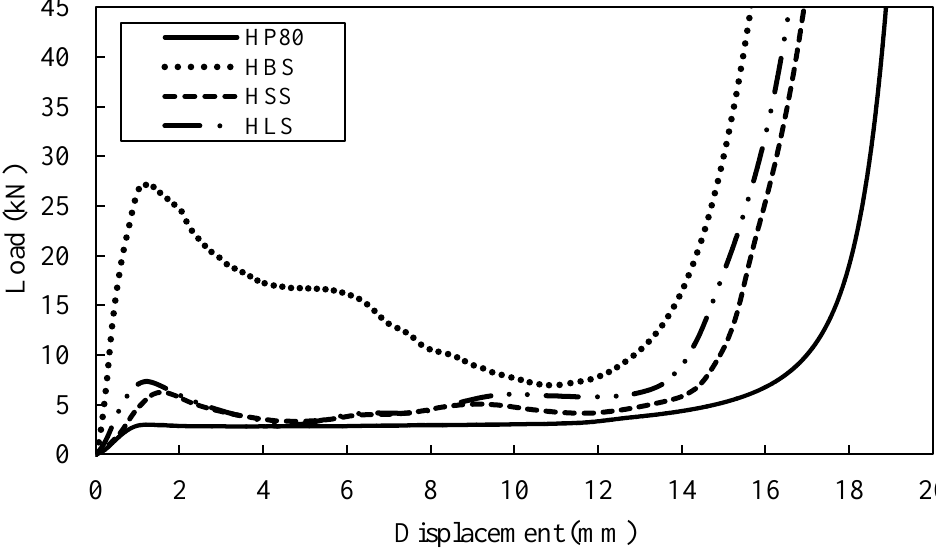
Figure 8. Load-displacement curve for HP80 reinforced with different type of single tubes. Based on the energy absorption under the load-displacement curves for both F50 and HP80 foams, the bamboo reinforced foam structure offers an energy-absorbing capability greater than both PVC reinforced foam structures. The SEA values for FBS, FLS and FSS structures are found to be 17.9, 10.0 and 8.2 kJ/kg, respectively. In contrast, the SEA value for HBS, HLS and HSS are 24.5, 10.9 and 10.1 kJ/kg, respectively. Previous study by (D/t = 4.6) reinforced foam structure which is almost similar to the value for FBS and